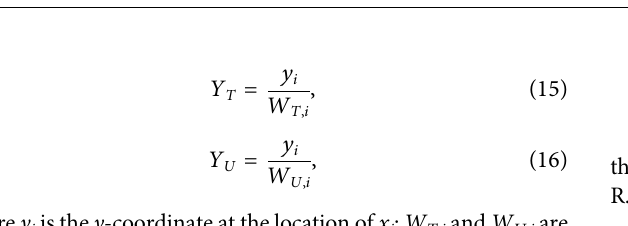
FIGURE 11 | Transverse pro fi les ofnormalized temperature defect and normalized velocity defect. (A) T df+ in the LBE, Pr = 0.025; (B) T df+ in the air, Pr = 0.71; (C) u df + ; (D) R.M.S. of